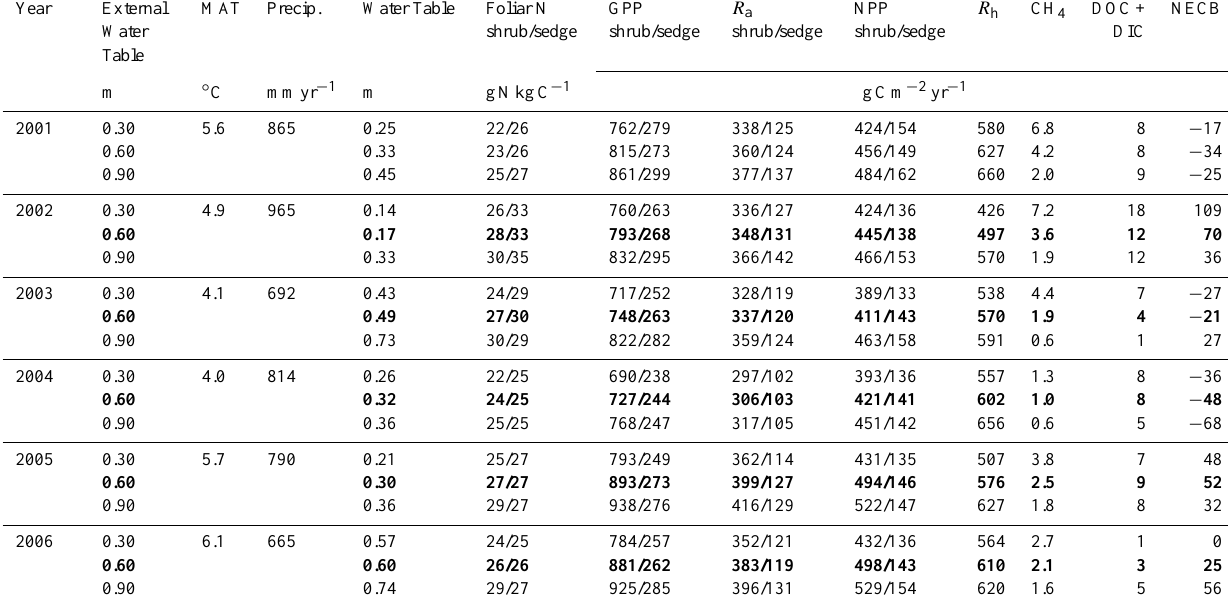
Table 3. External WTD, mean annual temperature (MAT), total precipitation, average WTD from hummock surface between DOY 120 and 300, foliar N content at anthesis, gross primary productivity (GPP), autotrophic respiration ( R a ) , net primary productivity (NPP), het- erotrophic respiration ( R h ) , methane emissions (CH 4 ) , export of dissolved organic and inorganic C (DOC + DIC), and net ecosystem carbon balance (NECB = NEP – CH 4 – DOC – DIC), averaged for hummock and hollow landscape positions, modelled for a boreal fen at Lost Creek, WI. Values at 0.60m in bold are the same as those in Table